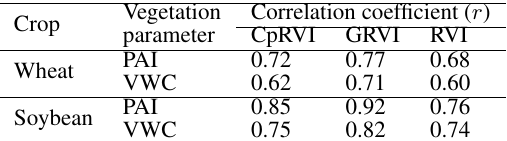
Table 3. Correlation of Vegetation Indices with PAI and VWC for wheat and